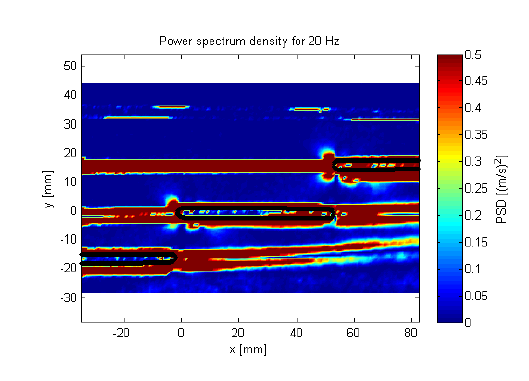
Fig. 6b. PSD scalar map for 20Hz, 20m/s for v-component.